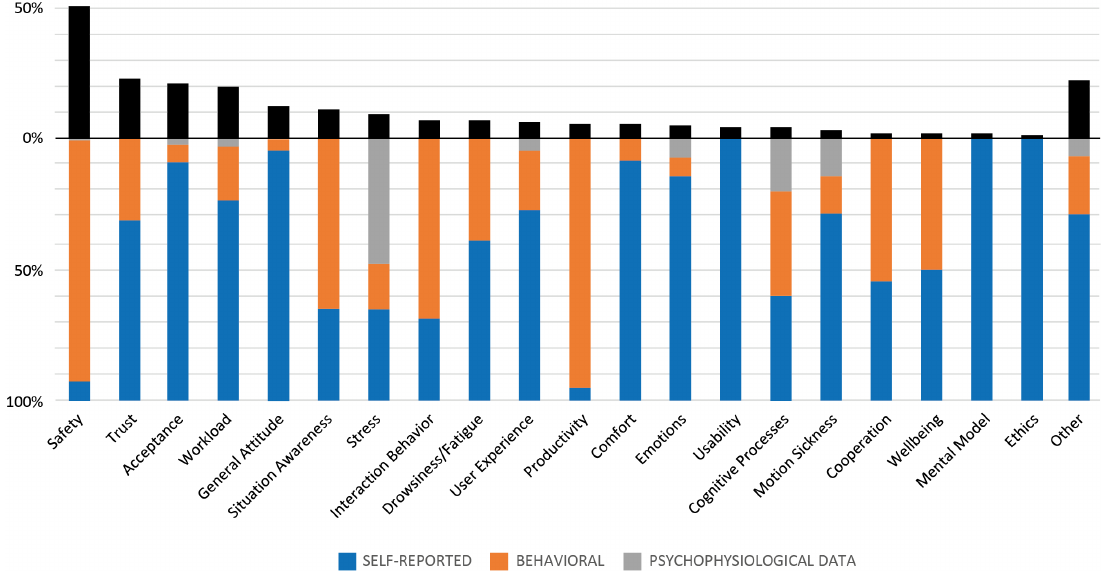
Figure 1. Frequencies of studied constructs ( upper row ) and used data types ( bottom row